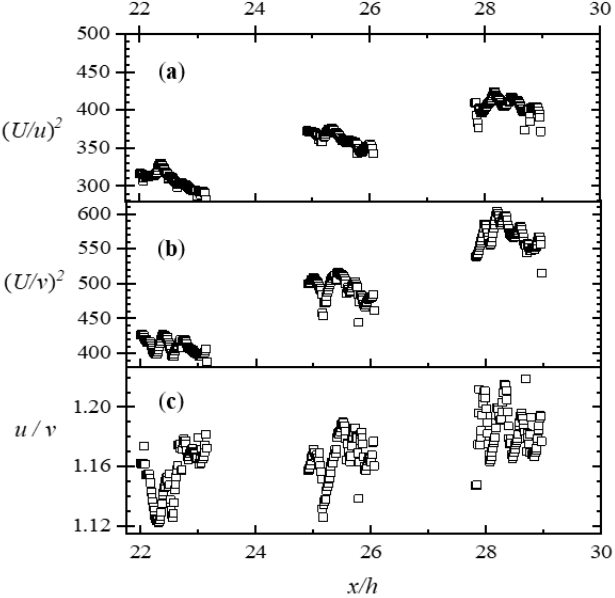
Figure 4. Streamwise variations of ( a ) ratio of mean streamwise velocities to streamwise turbulence intensities; ( b ) ratio of mean streamwise velocities to wall-normal turbulence intensities; and ( c ) ratio of streamwise turbulence intensities to wall-normal turbulence intensities. The plots are extracted from the mid-depth of the flow.